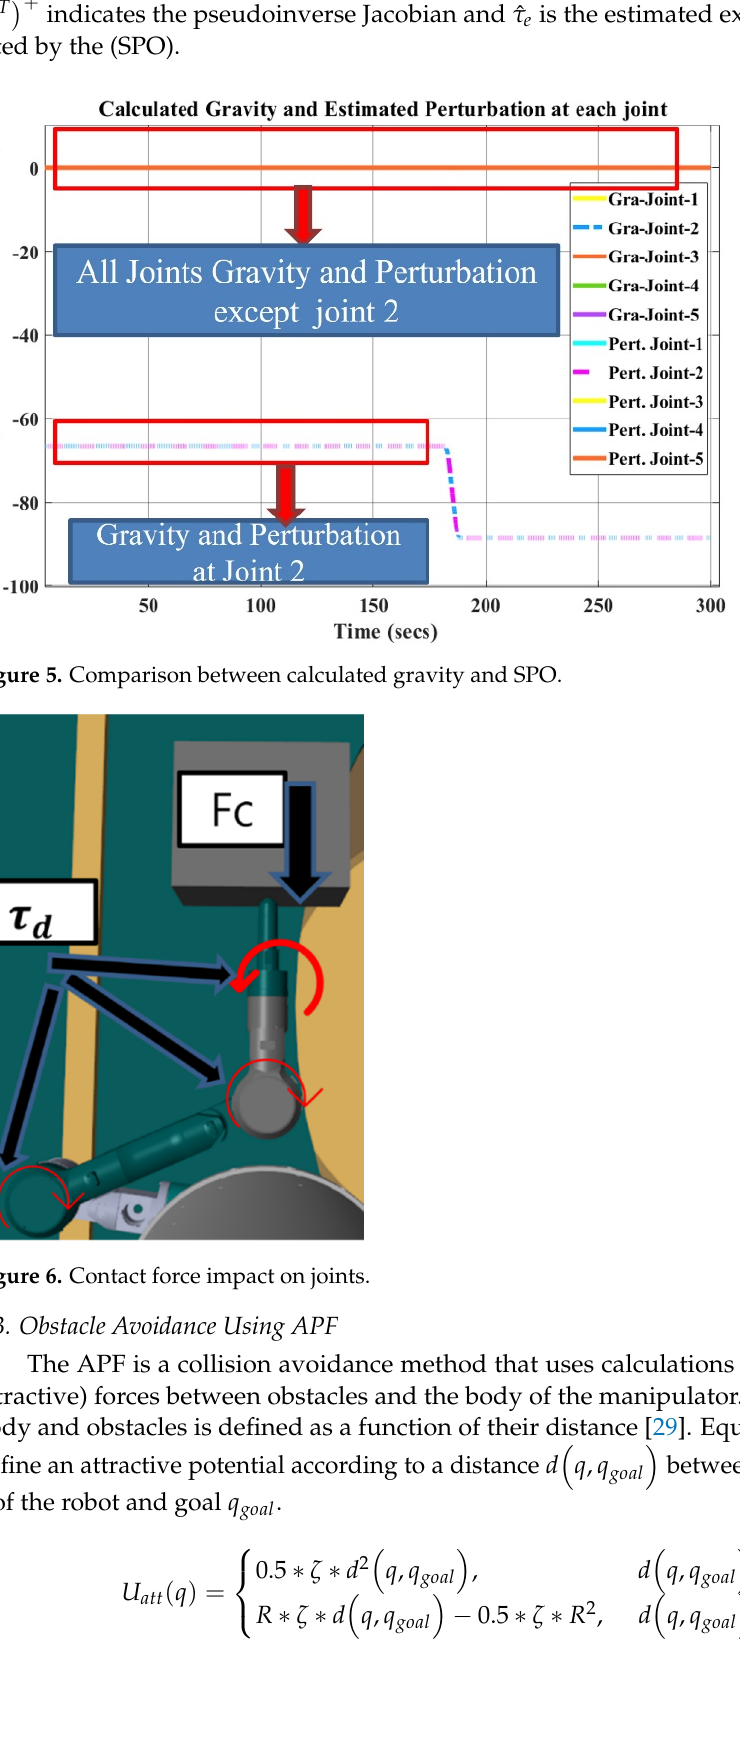
Figure 6. Contact force impact on joints.